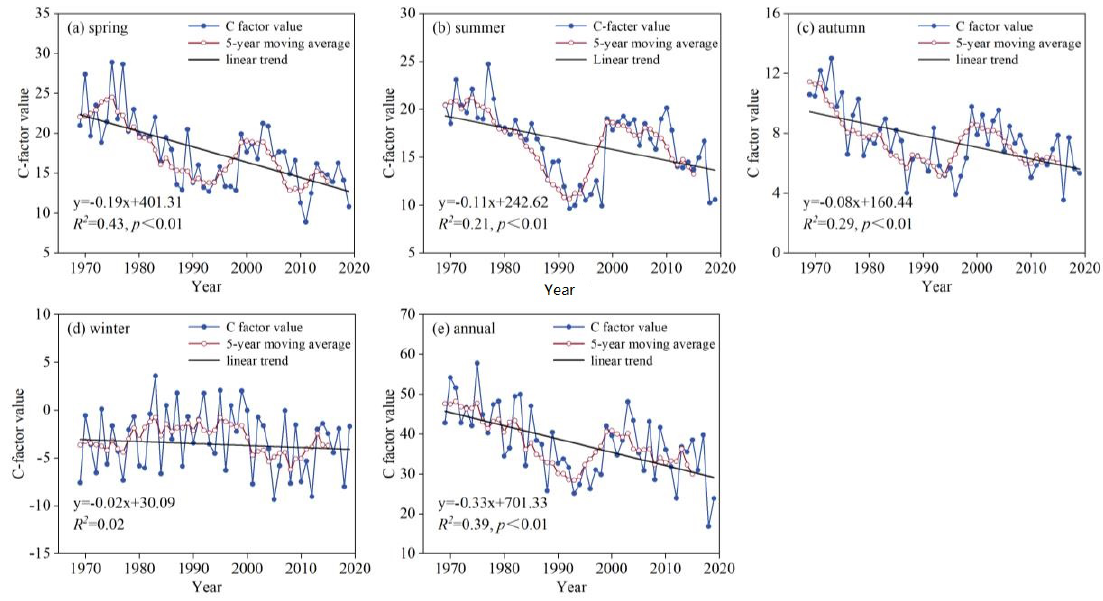
Figure 2. Variance tendency of C-factor value in ( a – d ) seasonal and ( e ) annual scales (50